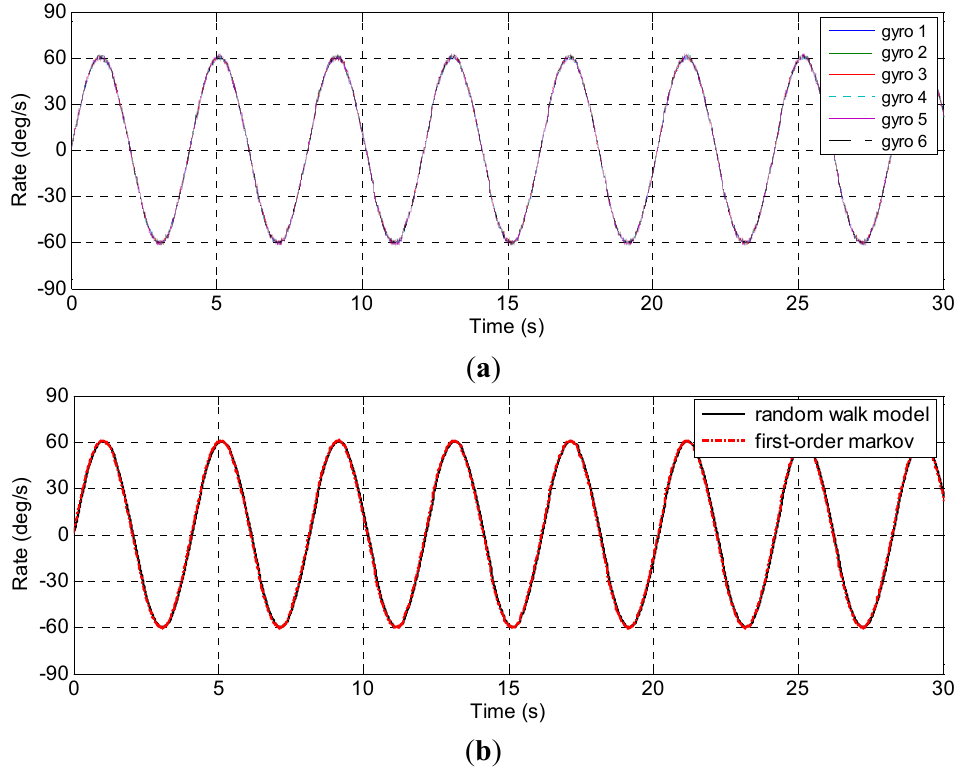
Figure 9. Sinusoidal rate test of the virtual gyroscope. ( a ) Outputs of the individual gyroscopes; ( b ) Outputs of the virtual gyroscope; ( c ) Estimated rate